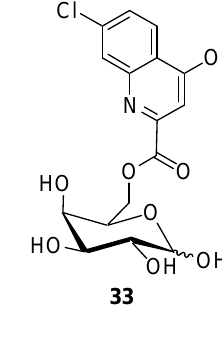
Prodrugs and GLUT 1 system.